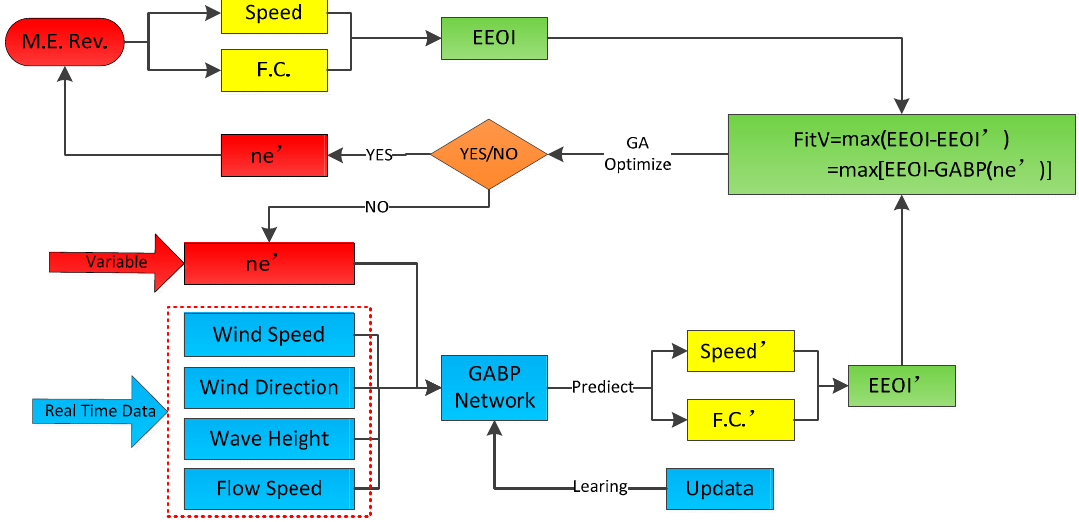
Figure 10. The dynamic optimization algorithm flow.